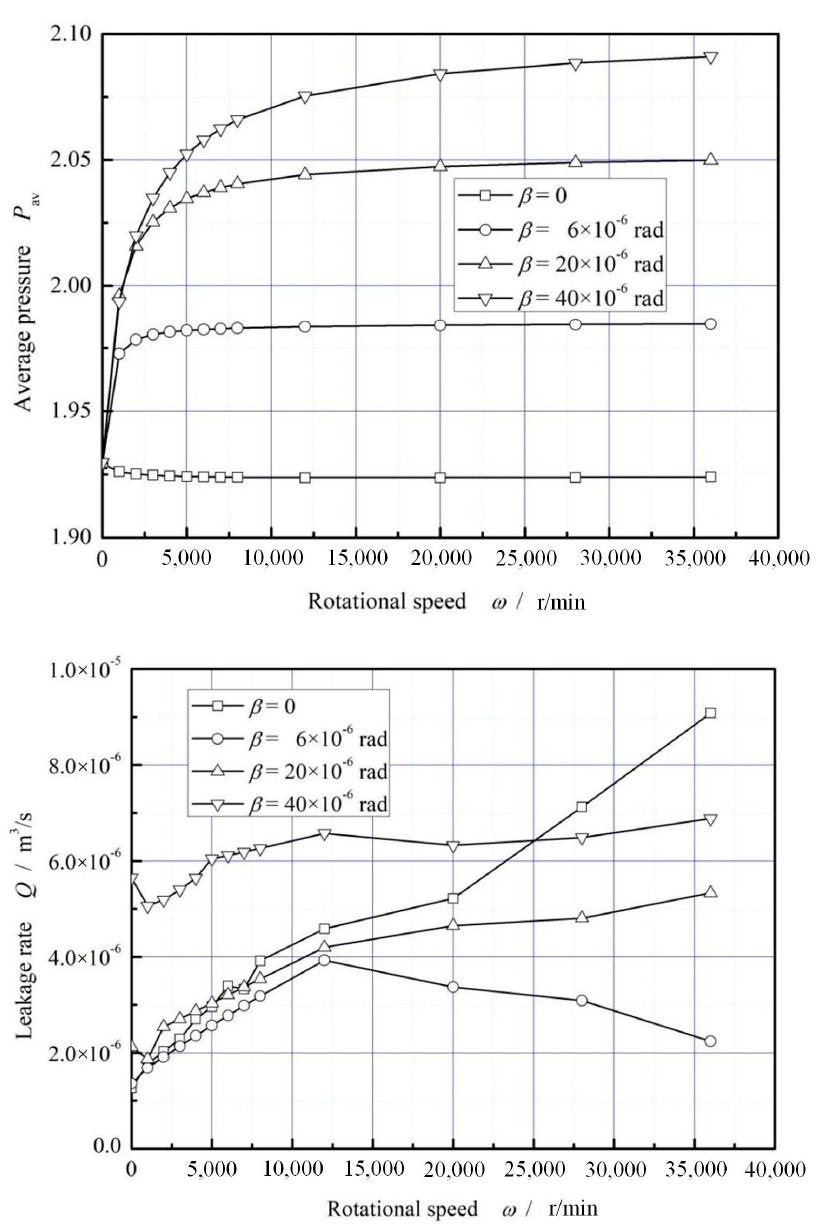
Figure 8. Influence of rotating speed on dimensionless mean pressure and leakage. ( p i = 0.2 MPa, T in = 580 K, T out = 380